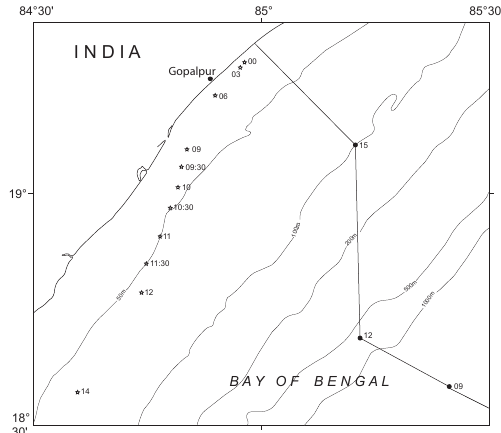
Figure 1. Track of the Cyclone Phailin from 8 October 2013 03:00UTC to 13 October 2013 06:00UTC.